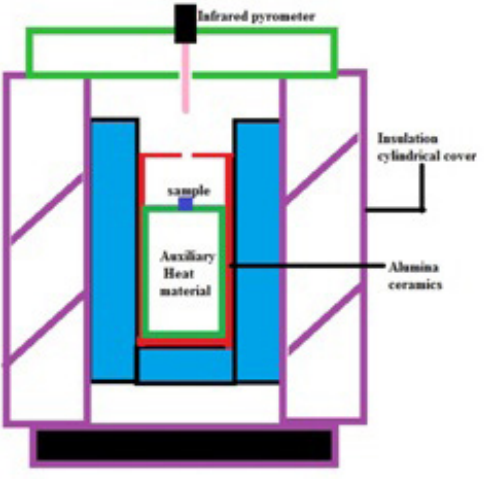
Figure 2. Schematic layout of the microwave sintering setup.